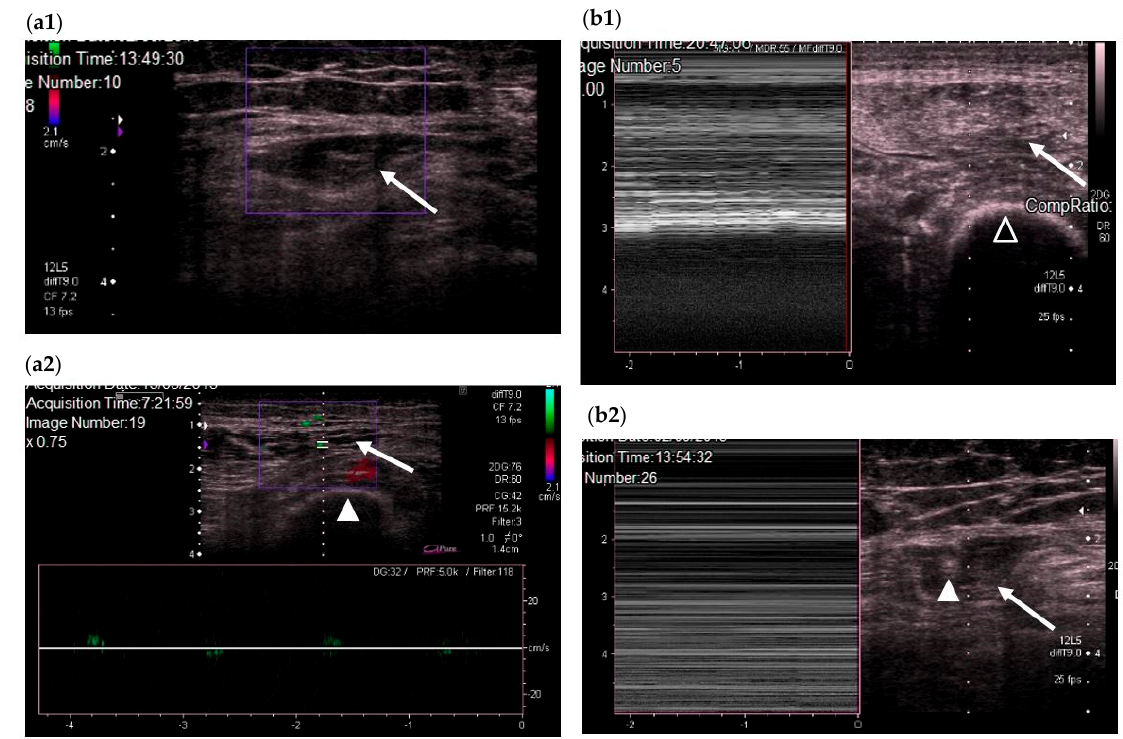
Figure 3. ( a ) Transversal QRF muscle US scan and color Doppler. ( a1 ) QRF muscle without vascularization (echogenicity Category 3). ( a2 ) QRF muscle with vascularization (echogenicity Category 2): the femur (arrowhead) and the QRF muscle (arrow). ( b ) Transversal US scans and M-mode; ( b1 ) QRF muscle (arrow) with fasciculations (echogenicity Category 2) and the femur (black arrowhead); ( b2 ) QRF muscle without fasciculations (echogenicity Category 3). QRF tendon of 3.6 mm (white arrowhead) and the QRF muscle (arrow). QRF: quadriceps rectus femoris, US: ultrasound.